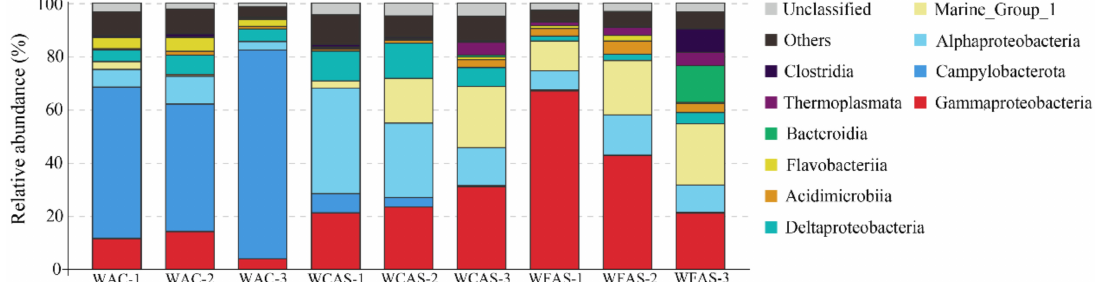
Figure 2. The diversity and distribution of microbial sequence tags in the libraries of seawater samples. Libraries of the seawater of animal community (WAC) are indicated by WAC-1, WAC-2, and WAC-3; libraries of the seawater closely above the seepage (WCAS) are indicated by WCAS-1, WCAS-2, and WCAS-3; libraries of the seawater far above (60 m, 120 m, and 220 m) the seepage (WFAS) are indicated by WFAS-1, WFAS-2 and WFAS-3. The sequence tags were generated with the next-generation sequencing (NGS) platform and classified at the phylum / class level. Each color represents the percentage of the taxon in the total assemblage. The top 10 groups in each sample are labeled, and other groups are integrated as “Others”.